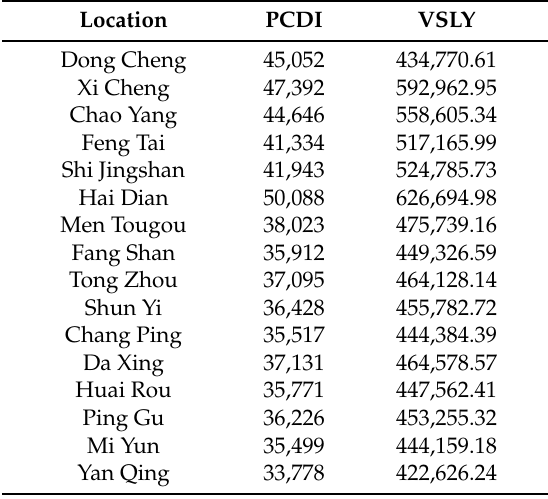
Table 3. VSLY for Beijing citizens (in